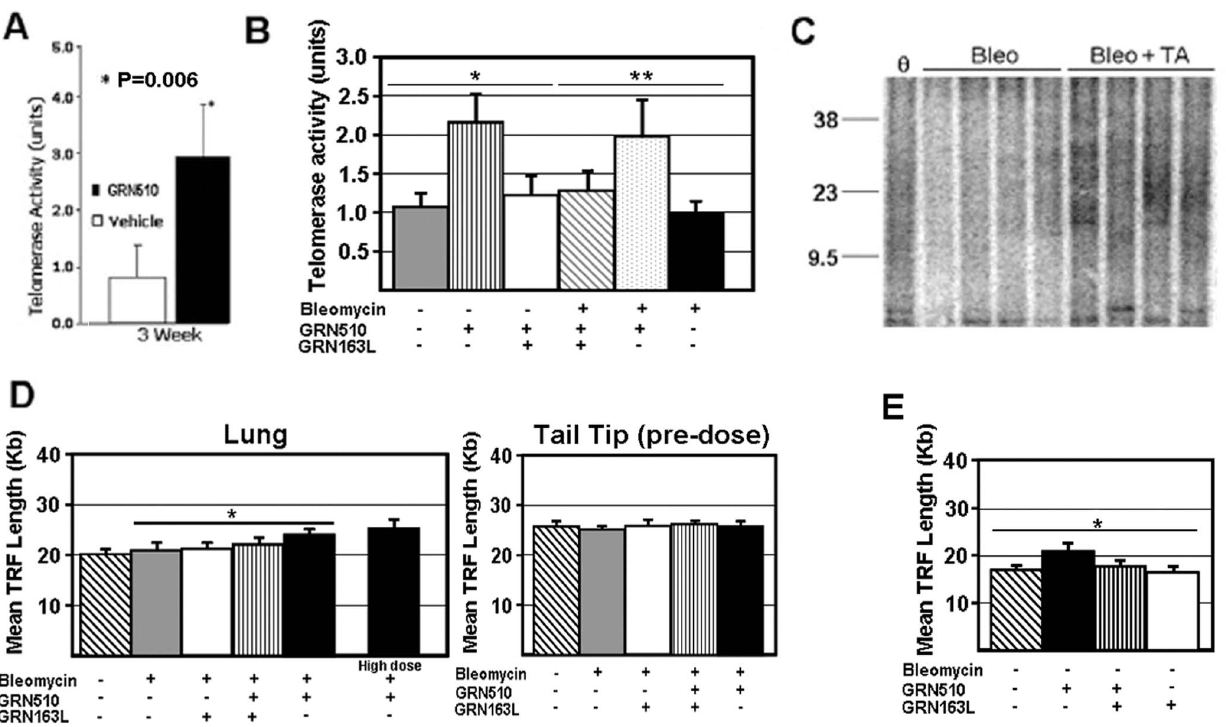
Figure 1. Treatment with GRN510 enhances telomerase function in the lung using a bleomycin-induced model of pulmonary fibrosis. A. Analysis of telomerase activity levels in lung tissue for Tert Het mice dosed with GRN510 at 10 mg/kg/d for 21 days post-Bleomycin treatment (23 days total). Intratracheal injection of Bleomycin was performed on day 0. The mean telomerase activity level for the GRN510 treated and vehicle control mice are shown (n=4–10 per group). The average activity level for the vehicle control group was arbitrarily assigned a value of 1.0. Asterisk, * denotes significant difference relative to the vehicle control mice (Student’s t Test). B. Analysis of the effect of telomerase inhibitor GRN163L on GRN510-mediated telomerase activation in the lung. Mice were dosed with GRN510 (10 mg/kg/d) and/or the telomerase inhibitor GRN163L (13 mg/kg/d) as indicated for 21 days (n=5–10 for all groups). The average activity level for the vehicle control group was arbitrarily assigned a value of 1.0. Asterisks, (*, **) denotes significance amongst the indicated groups (pvalue # 0.03, 1-way ANOVA; P # 0.01 comparing GRN510 + GRN163L treated group to GRN510 treated group Student’s t Test). C. Sample southern blot for analysis of terminal restriction fragment length of lung tissue after GRN510 (TA-telomerase activator) treatment. A control sample for untreated Tert Het mice is represented by ’ h ’. Size of molecular weight standards are shown on the left (Kb). D. Quantitative analysis of mean TRF length lung tissue after 3 weeks of GRN510 treatment. For each group, n=5–10. Asterisk * denotes significance amongst indicated groups; P=0.03, 1-way ANOVA). E. Mean TRF length analysis of PBS control mice. Analysis was performed after 3 weeks of dosing (all mice dosed as described above). N=4 per group. Asterisk, * denotes significance amongst groups (P=0.02, 1-way ANOVA). For all plots, mean 6 SEM is